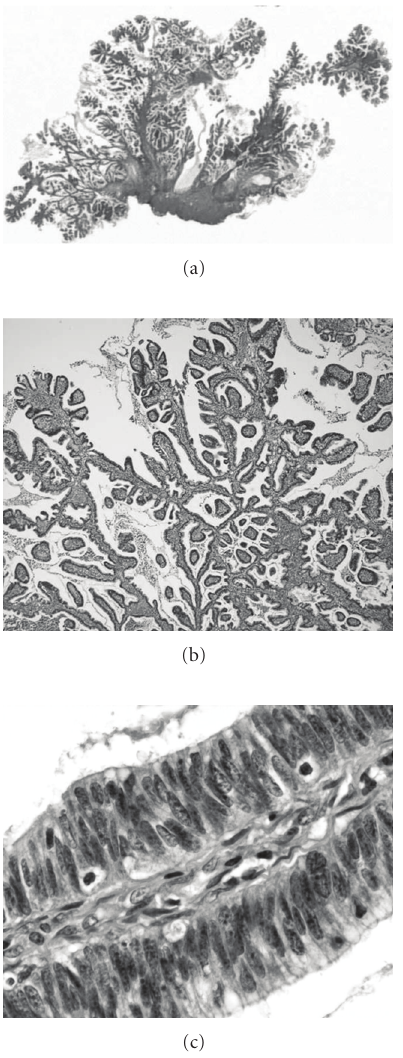
Figure 1: Typical histological patterns for villoglandular papillary adenocarcinoma of the cervix. (a) Tumor displaying thin and tall, well-formed papillary structures (hematoxylin and eosin, original magnification, x4), (b) Higher magnification of (a). Large glandular and papillary structures with broad stroma (hematoxylin and eosin, original magnification, x40), (c) Higher magnification of (b) (hematoxylin and eosin, original magnification,